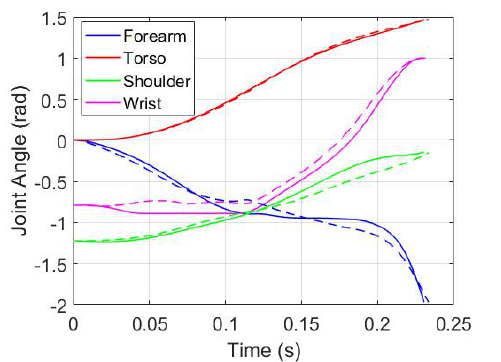
Figure 4. Joint angle displacement of the golfer